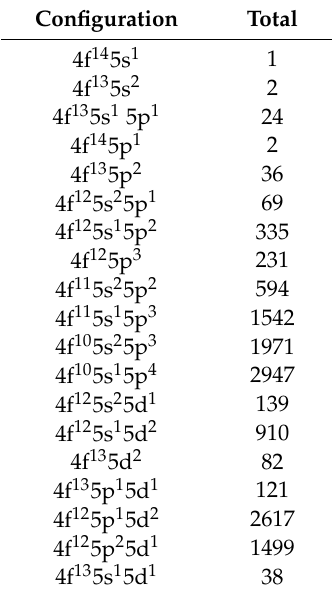
Table 8. List of configurations included and the number of fine-structure levels arising from each configuration of Pm-like W.